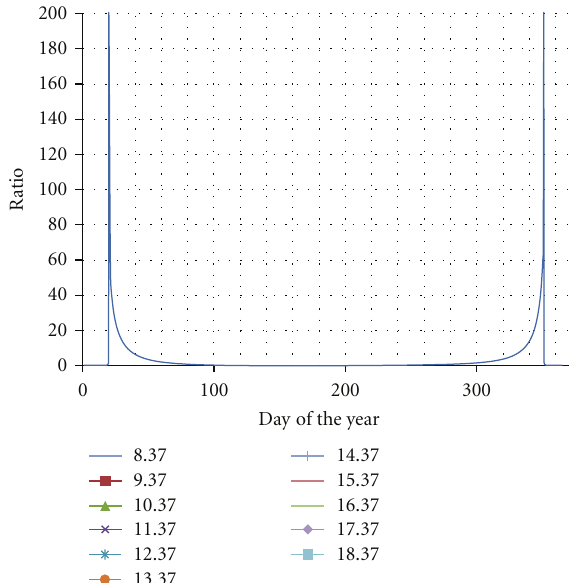
Figure 17: Ratio of mirror 1 along the year (shadows are consid-